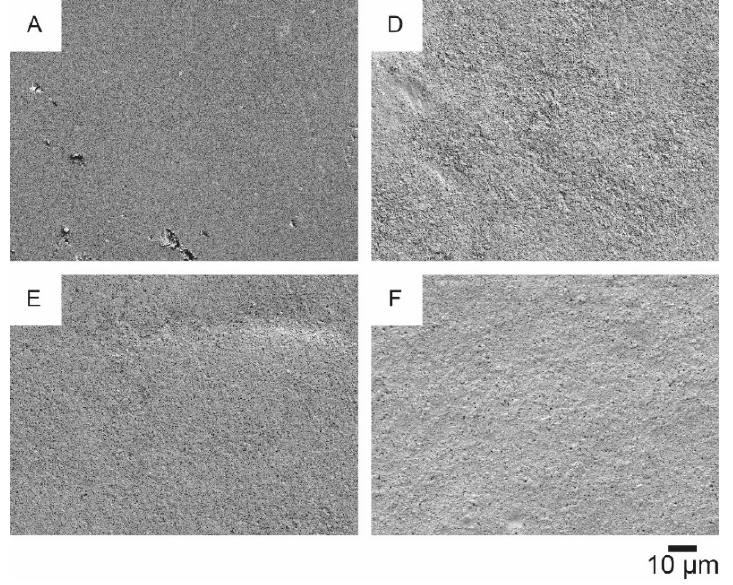
Figure 10. SEM images at a magnification factor of 1000 of the following substrates: p_e:smart paper type 2 ( A ), Koehler Type E ( D ), Algro Baress ( E ), Magno Satin ( F ).